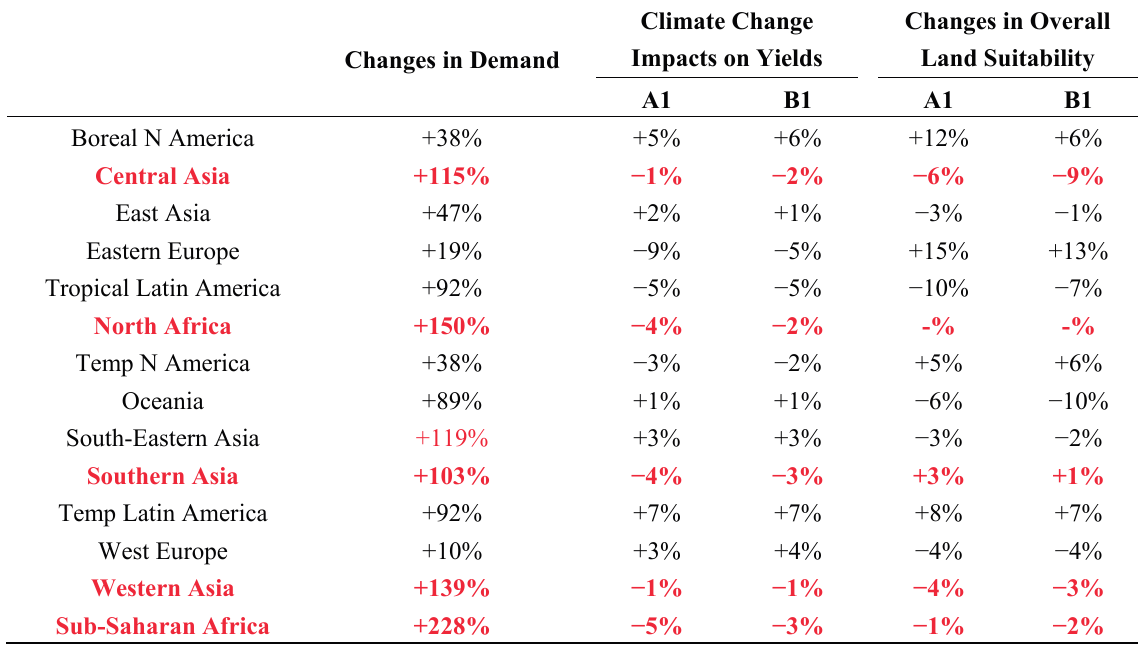
Table 5. A comparison of demand increases and negative climatic effects on agriculture. Countries where both factors will be significant are highlighted in red.